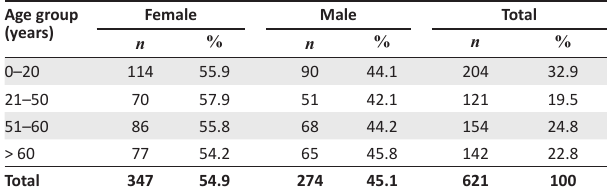
TABLE 1: Age and gender distribution of patients seen at the low vision clinic of the Department of Optometry, University of